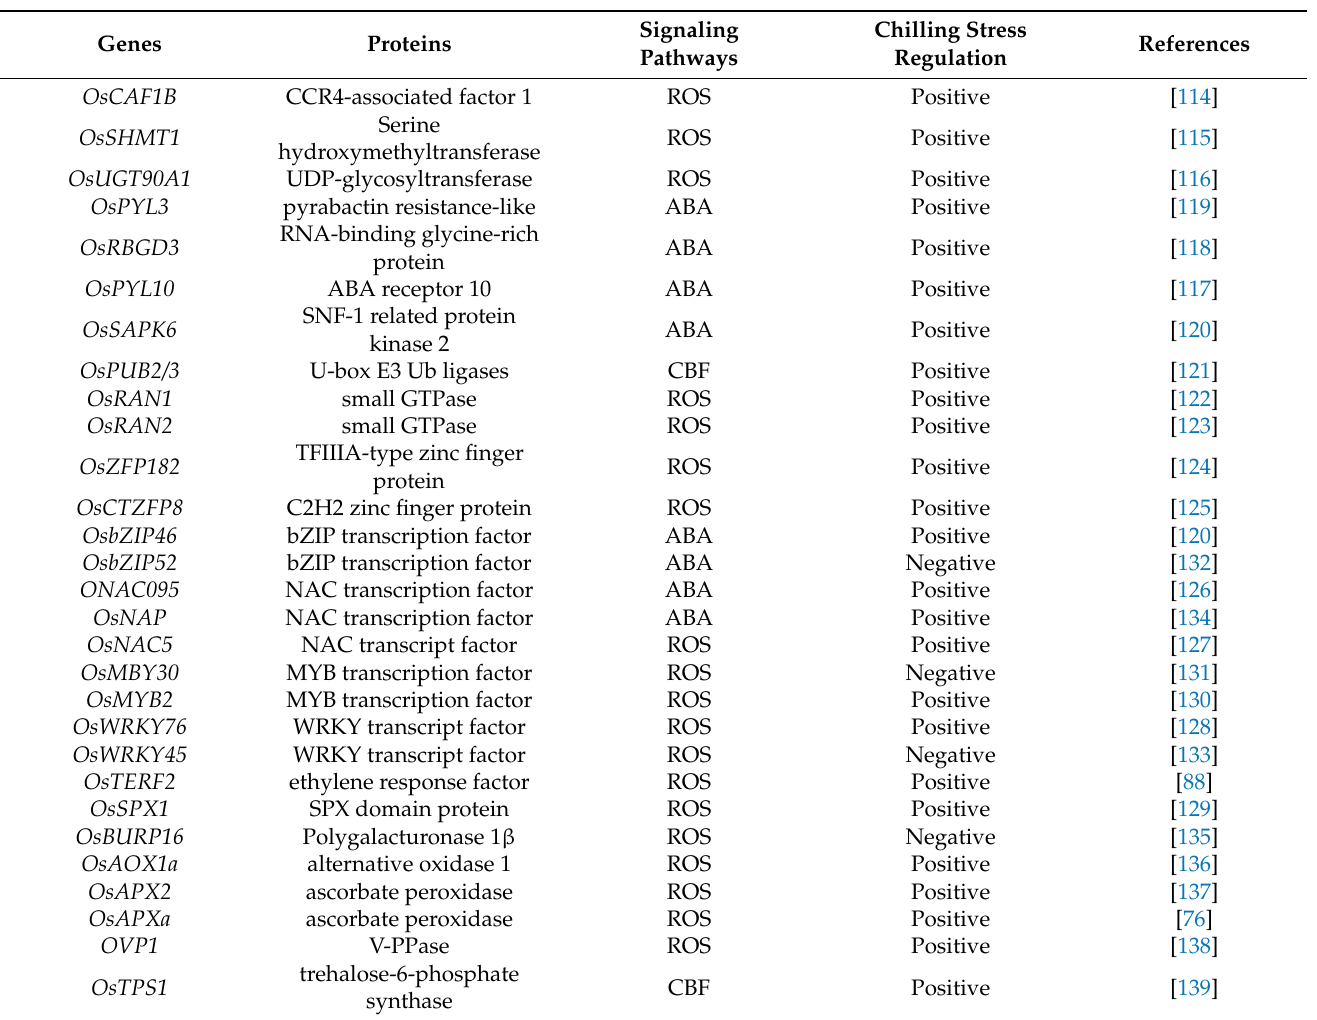
Table 2. List of transgenic chilling stress rice lines since